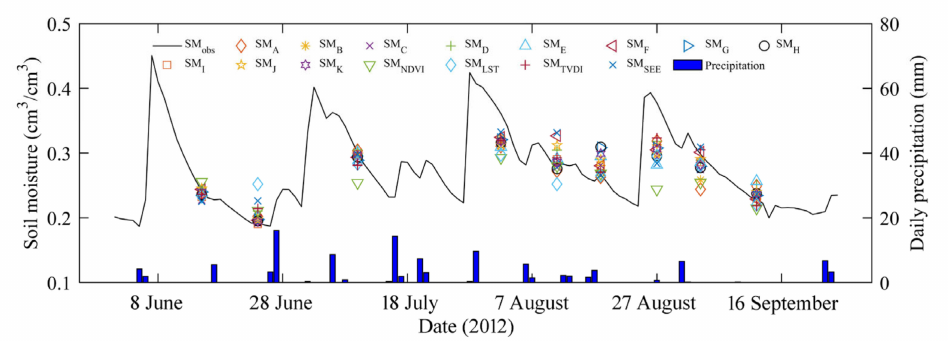
Figure 11. Comparison of the RF mapped with the observed soil moisture at 4 cm of Daman Superstation (SM obs : observed soil moisture, SM A to SM K : RF mapped soil moisture with 11 types of multiple auxiliary variables combinations, SM NDVI , SM LST , SM TVDI , and SM SEE : RF-mapped soil moisture with single auxiliary variables including NDVI, LST, TVDI, and SEE